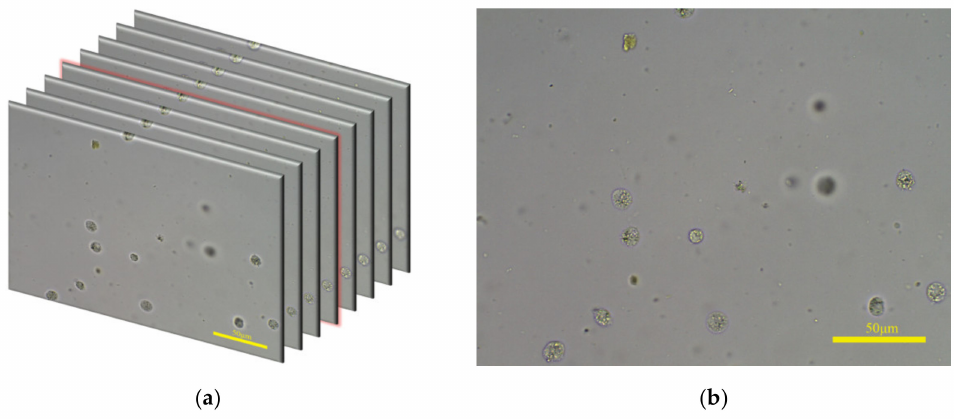
Figure 5. ( a ) One group of fecal microscopic images captured in autofocus process; some images are omitted for ease of interpretation. ( b ) The clearest image of the image group in ( a ).